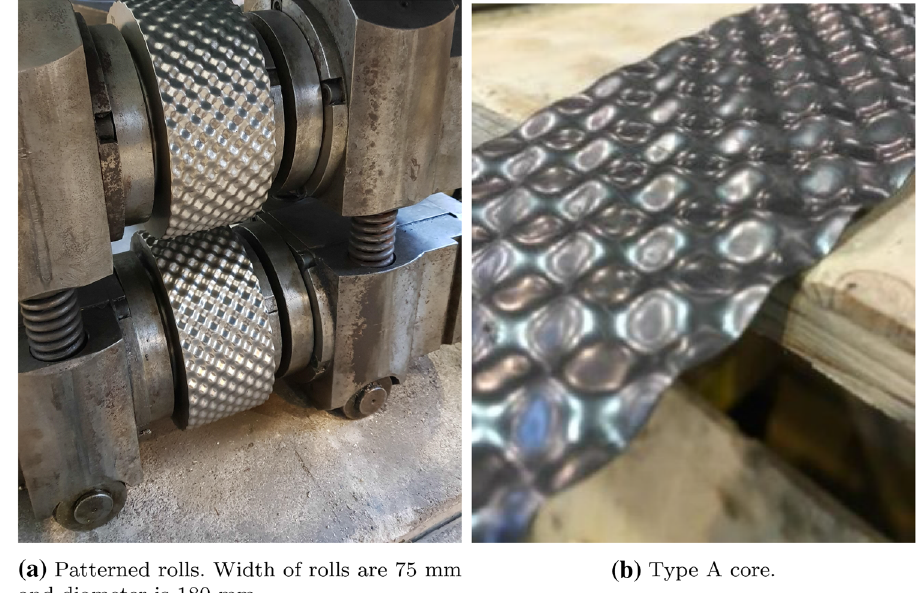
Fig. 2 Rolls ( a ) used for manu- facturing a specimen of the